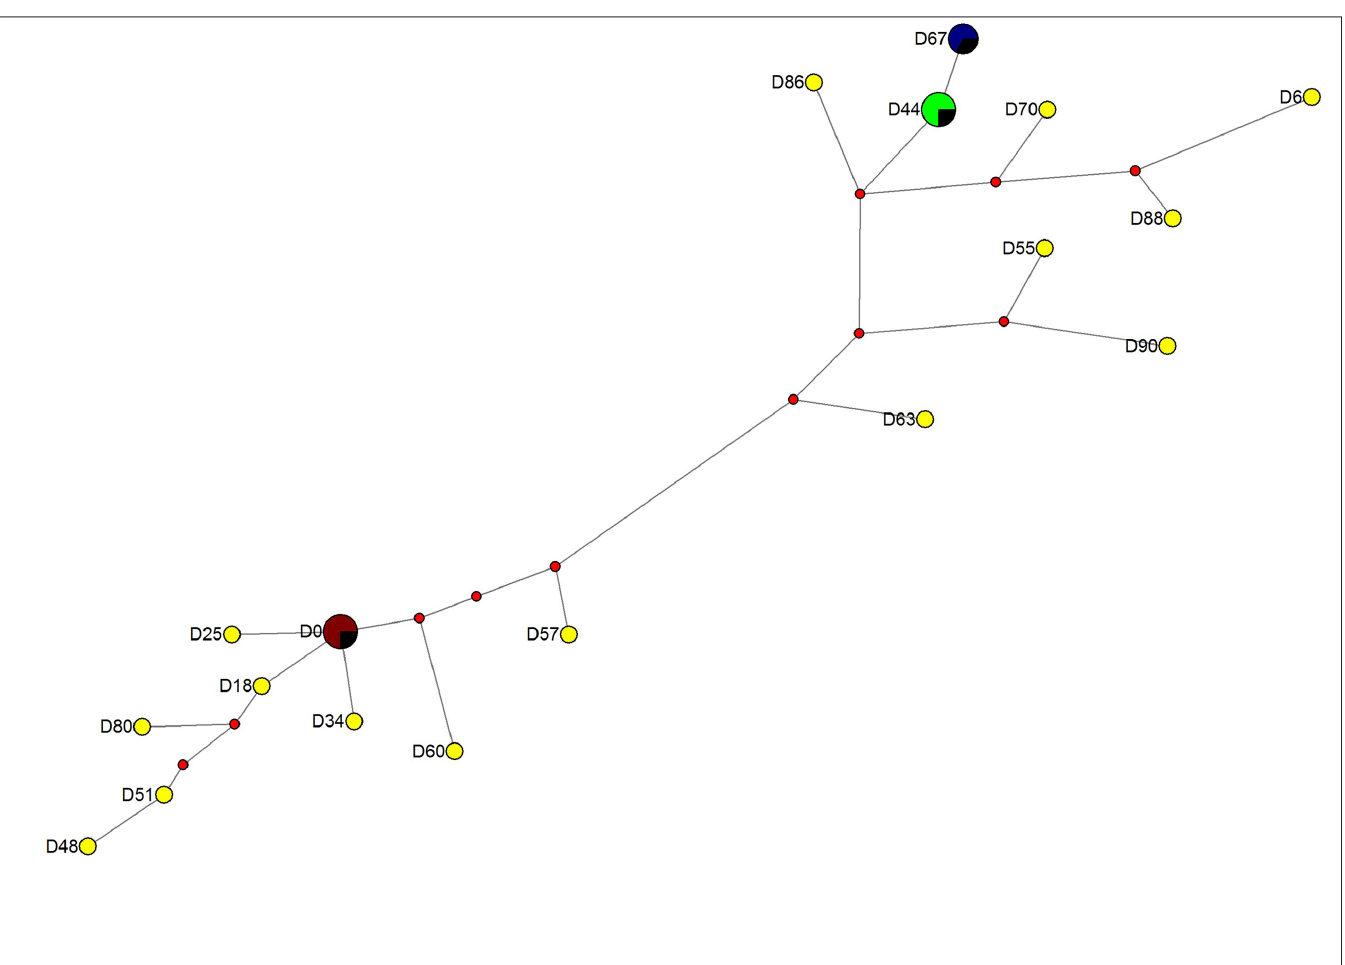
Fig 1. Median-joining network diagram for MS data. Diagram showing relationship of the different parasite generations in H63 parasite-line samples. The multilocus MS haplotypes profiles were constructed for each of the parasite generations using the 12 MS markers located across the P . falciparum genome. The 26 generations of the cultured P . falciparum field isolates analyzed formed 18 unique 12-loci microsatellite haplotypes. For allele sizes please refer to S4 Table. Each circle in the network represents a unique MS haplotype with the size of the circle being proportional to the number of isolates showing that particular haplotype. The red dots are hypothetical median vectors generated by the software to connect existing haplotypes within the network with maximum